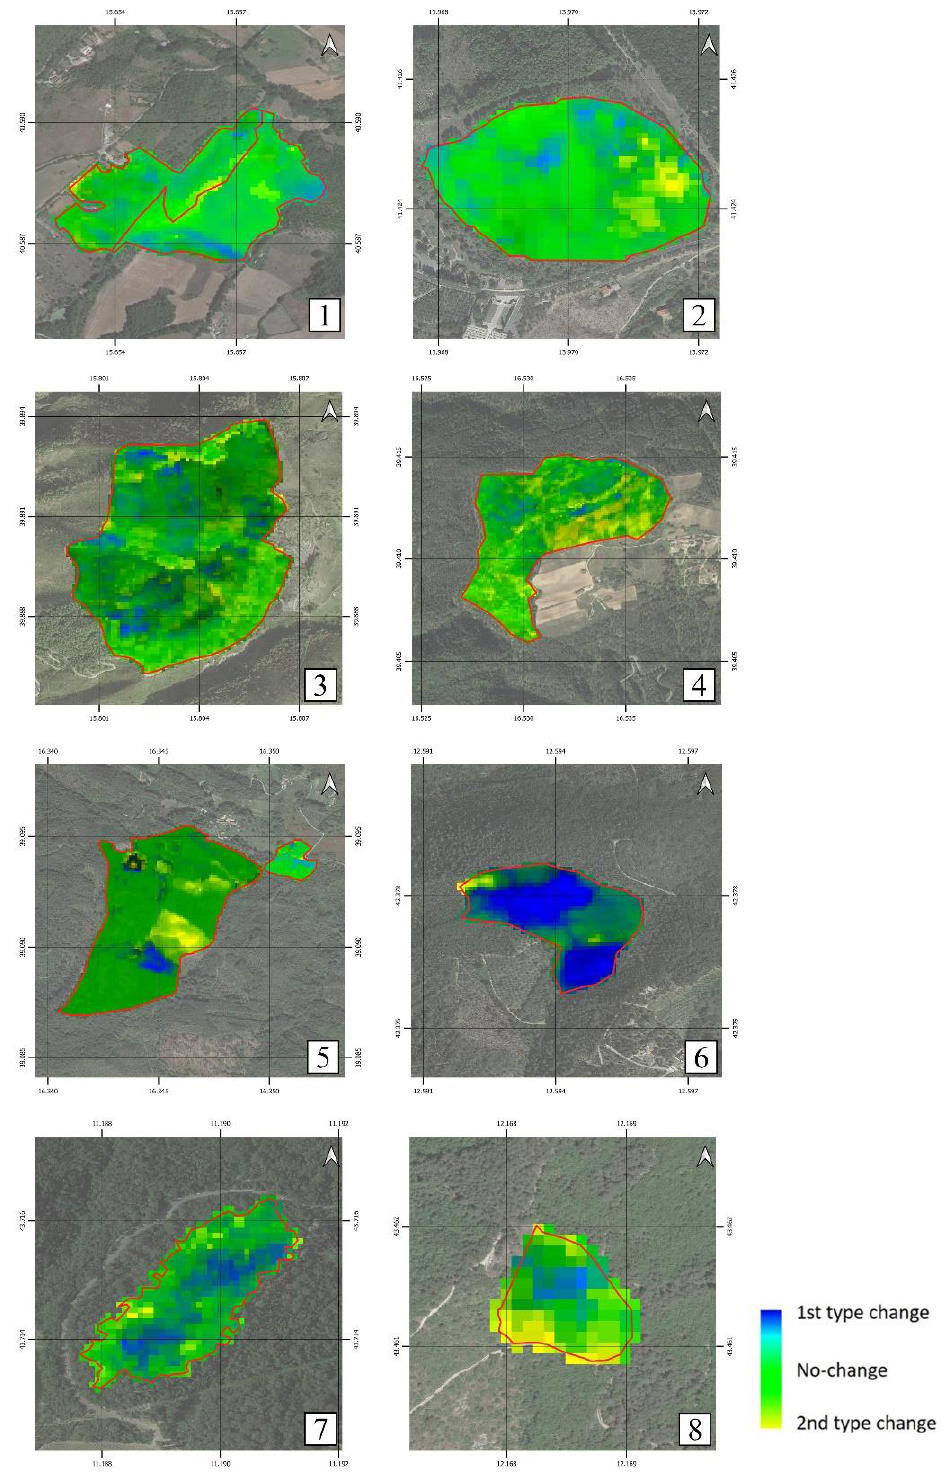
Figure 4. RGB of the results of the analysis applied to the fire-affected areas. The numbers correspond to the IDs shown in Table 1.